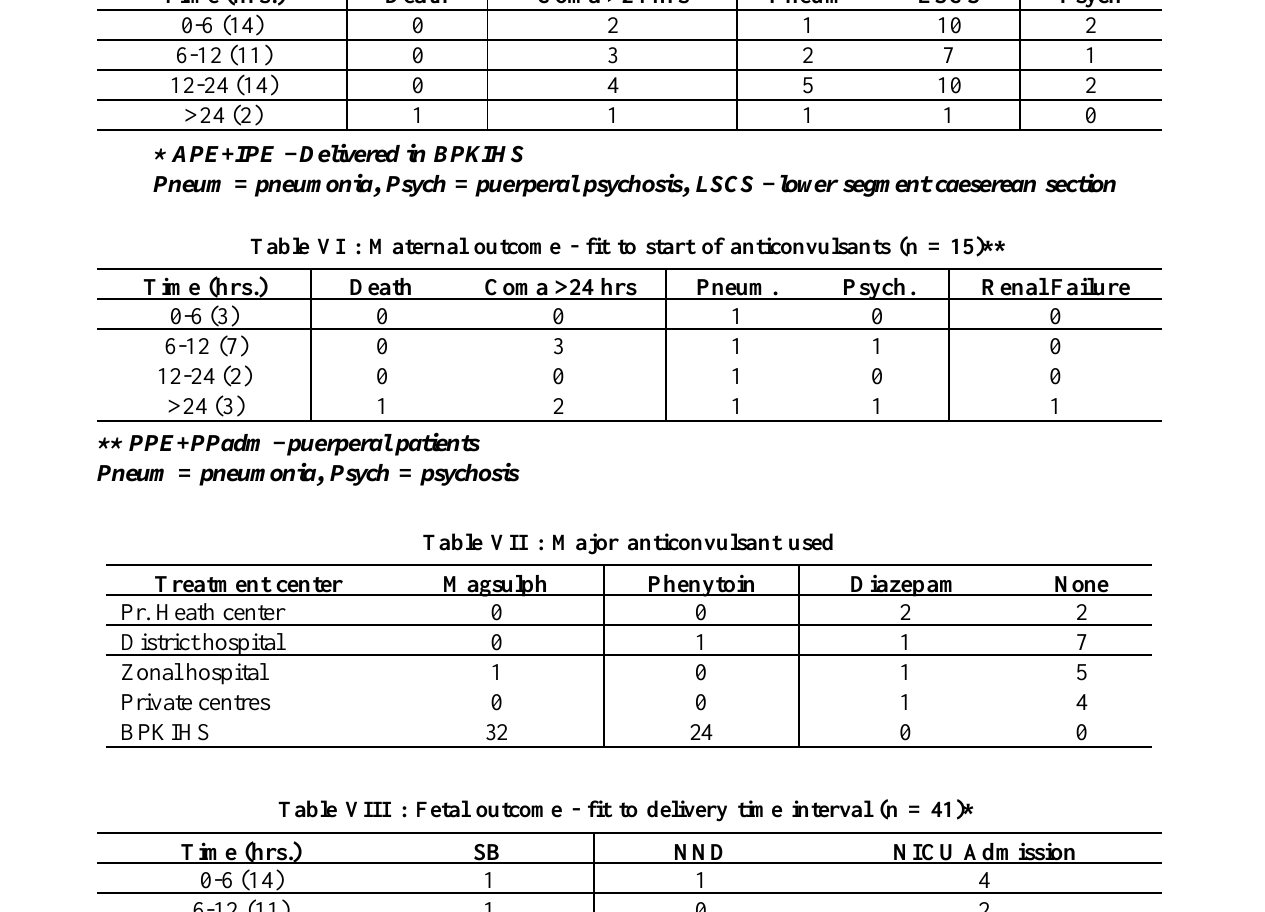
Table V : Maternal outcome - fit to delivery time interval (n = 41)* Time (hrs.)